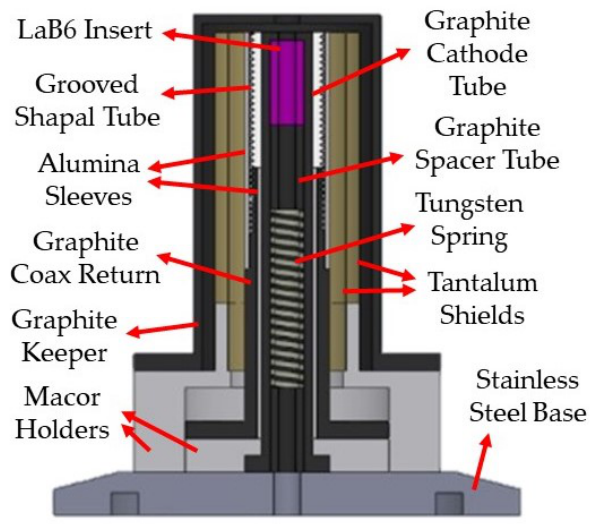
Figure 4. Cross-sectional view of the coaxial–heater hollow